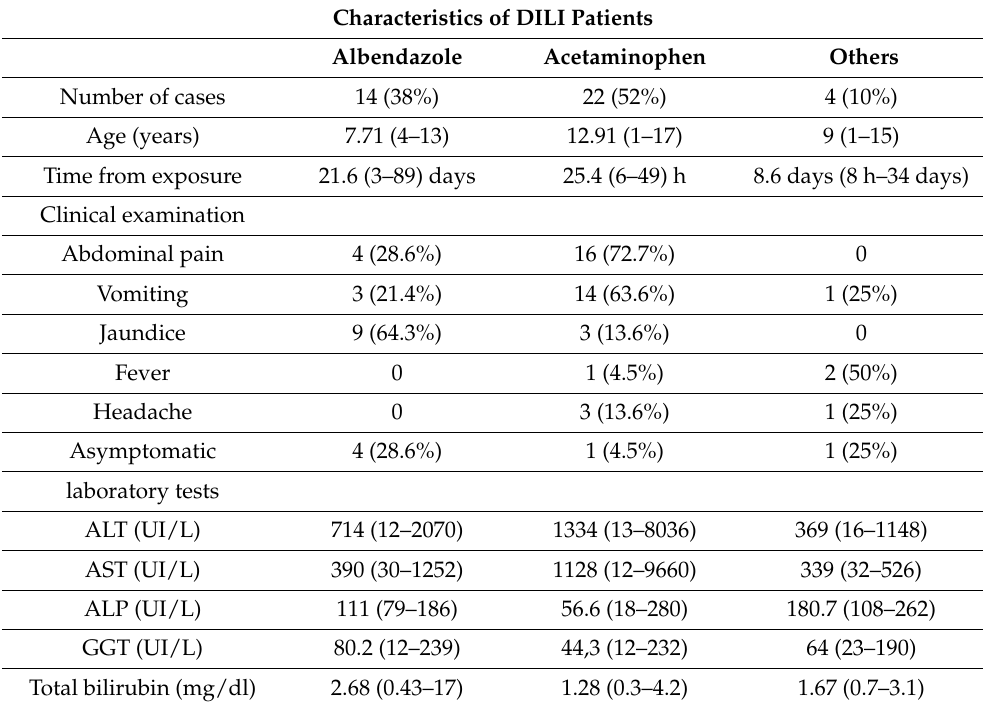
Table 1. Demographics, clinical parameters, and outcomes of patients with DILI. Characteristics of DILI